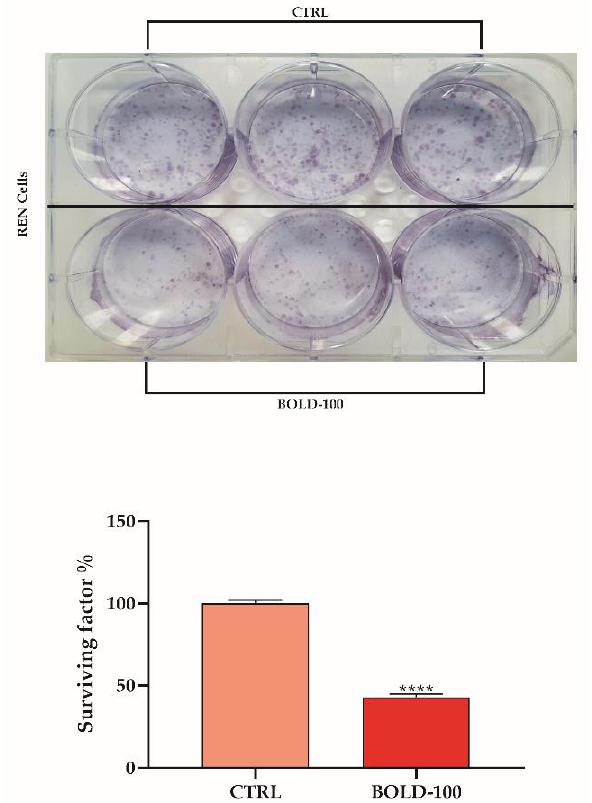
Figure 1. BOLD-100 reduced colony formation in REN cells. Colony formation ability measured in cells exposed for 48 h to BOLD-100. Data are means ± SD from five independent treatments, and indicated as surviving factor %. Asterisks on bars indicate statistical differences (**** p < 0.0001, unpaired t test).